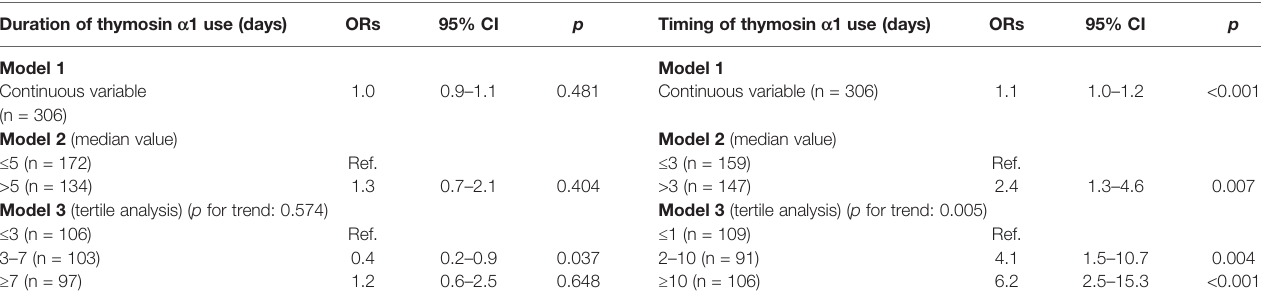
TABLE 5 | Association between the duration/timing of thymosin a 1 use and non-recovery rate. Duration of thymosin a 1 use (days)